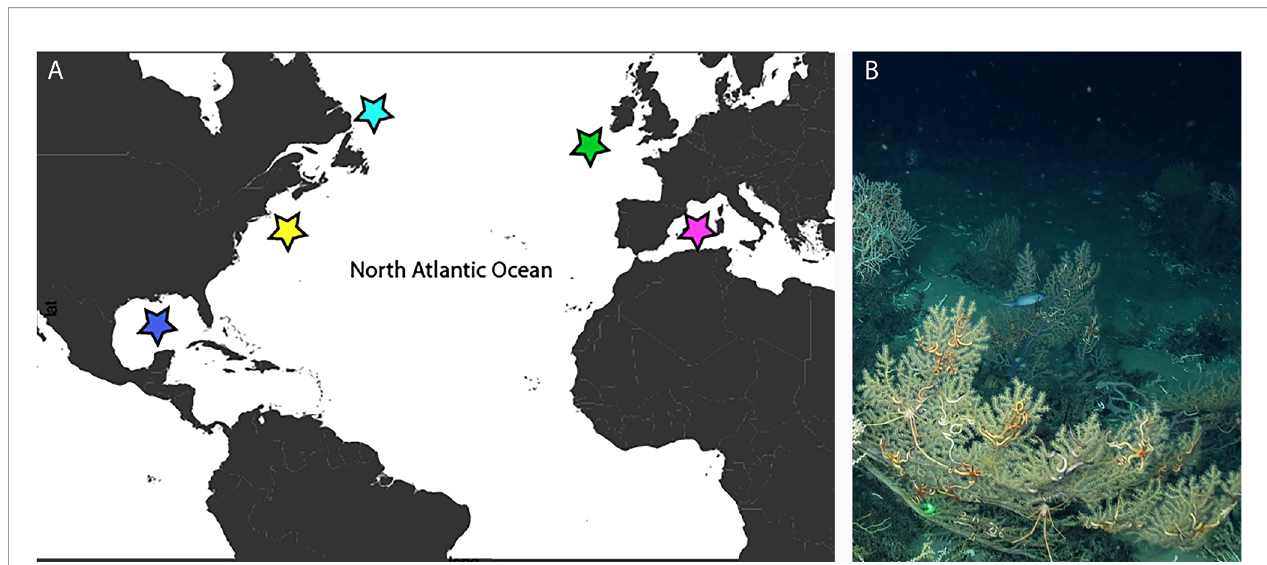
FIGURE 1 | (A) Map of sampling locations. blue = Gulf of Mexico, yellow = NE United States, light blue = Canada, green = Ireland, pink = Mediterranean Sea. (B) Paramuricea sp. 3, with associated brittle stars and squat lobsters, in the Gulf of Mexico at 1050 m